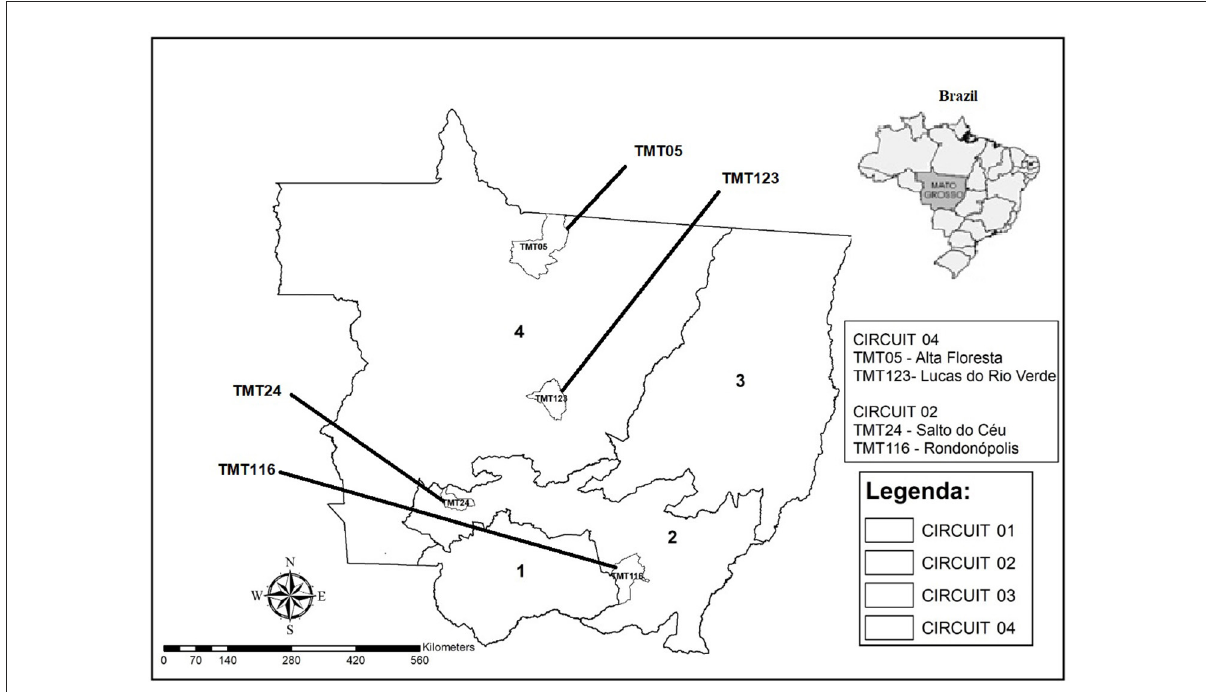
FIGURE1 Map of Mato Grosso state with the municipalities demarcating the origins of the strains selected for genome sequencing.